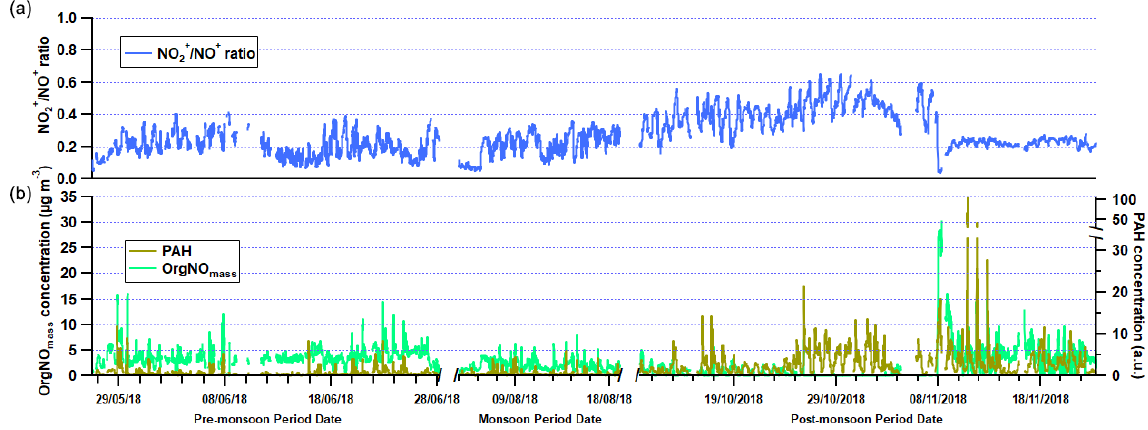
/ NO + ratio in the three measurement periods. (b) Time series of polyaromatic hydrocarbon (PAH) Figure 4. (a) Time series of NO + 2 uncalibrated concentrations and organic nitrogen oxide species (OrgNO mass ) concentrations.